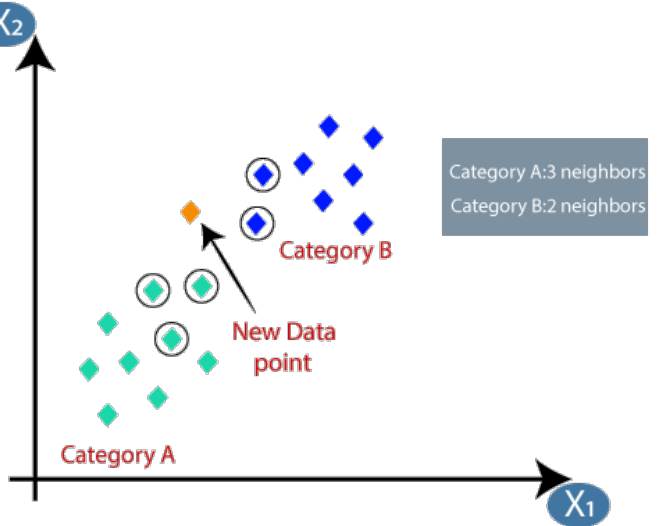
Figure 7. Three NN of KNN classifier [30].